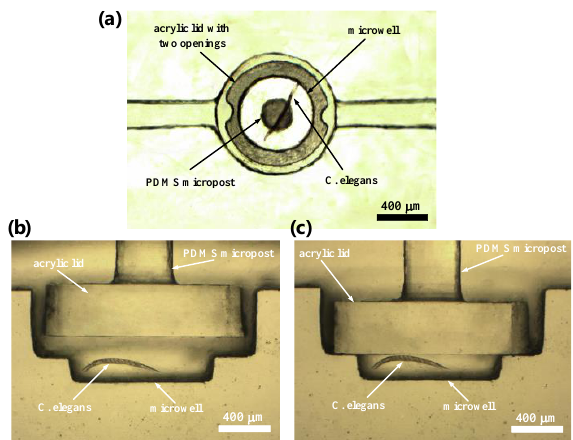
Figure 2. ( a ) A bottom view image of a single adult C. elegans entrapped in a microwell and an acrylic lid with two openings set above the microwell. ( b , c ) Side view images of a pneumatically driven acrylic lid above the microwell to controllably open and seal the microwell.